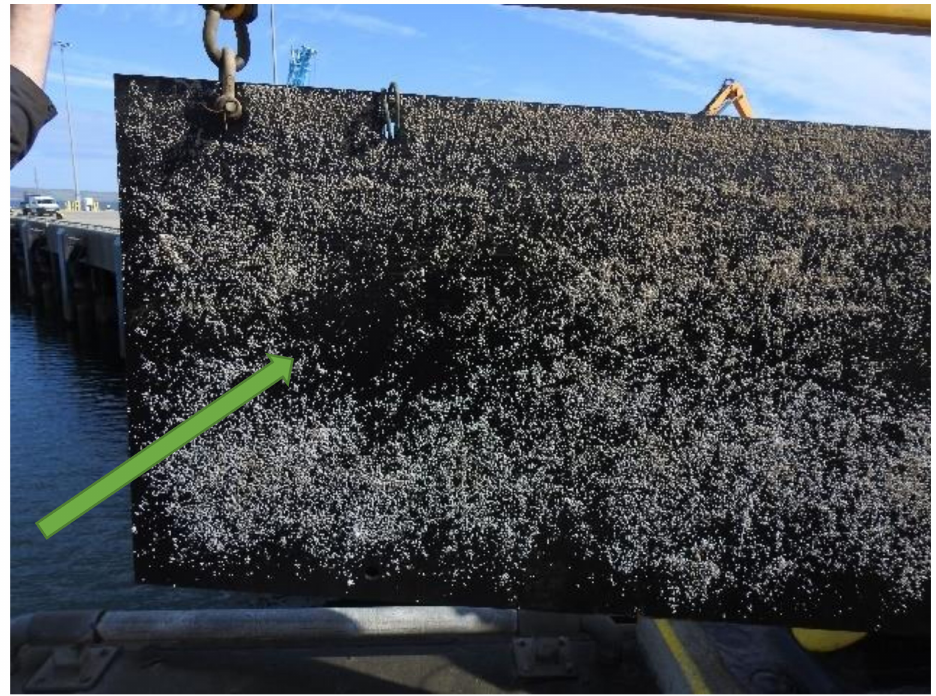
Figure 17. Biofouling removal using an HPUT. The green arrow shows the location of the HPUT at the back of the